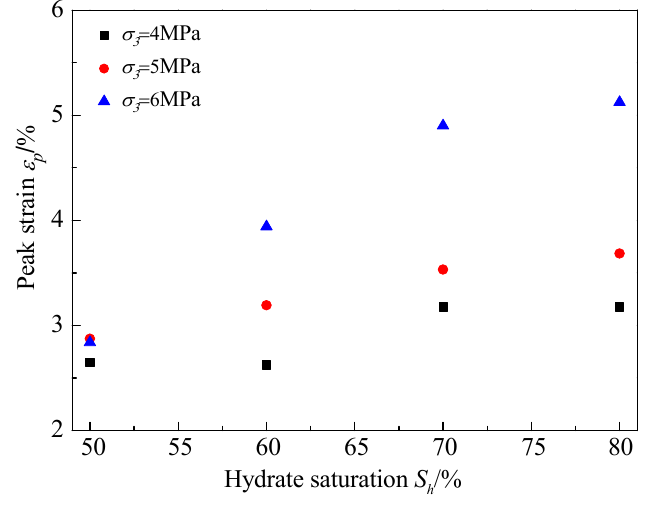
Figure 13. Variation of the peak strain with the hydrate saturation.